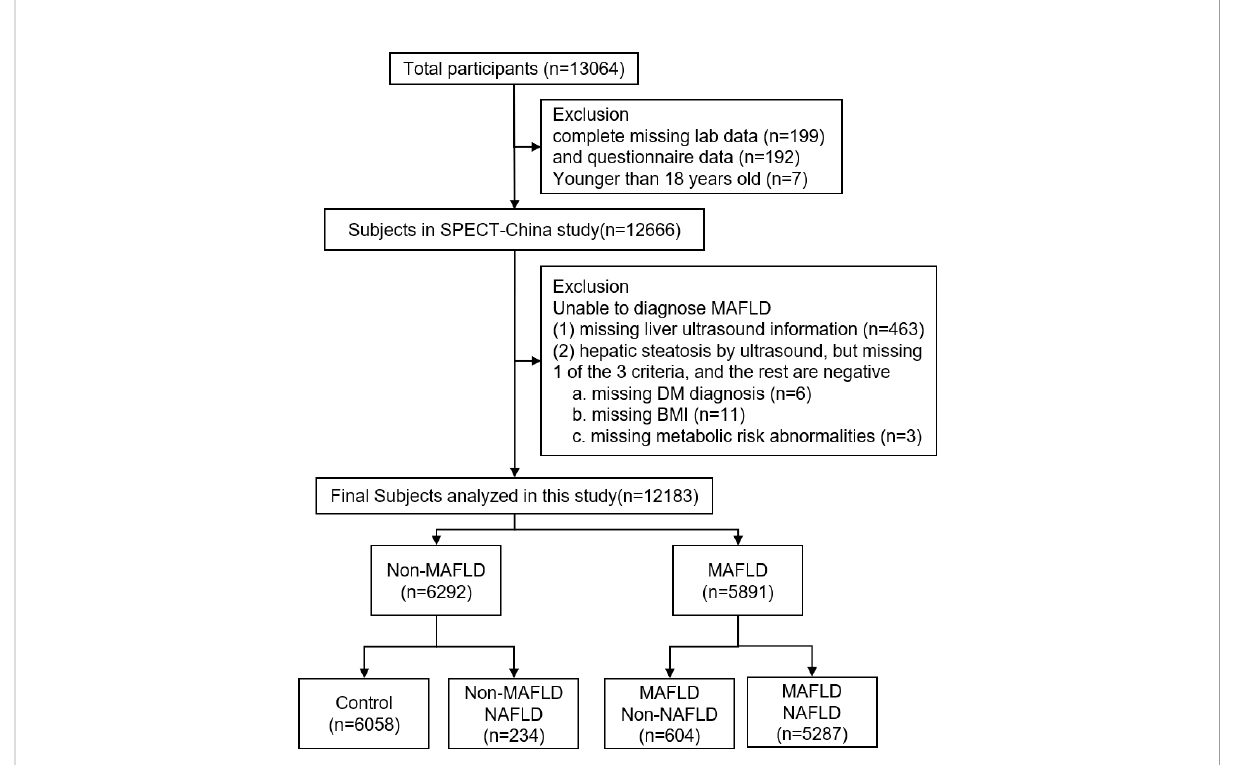
FIGURE 1 The inclusion and exclusion criteria of the study